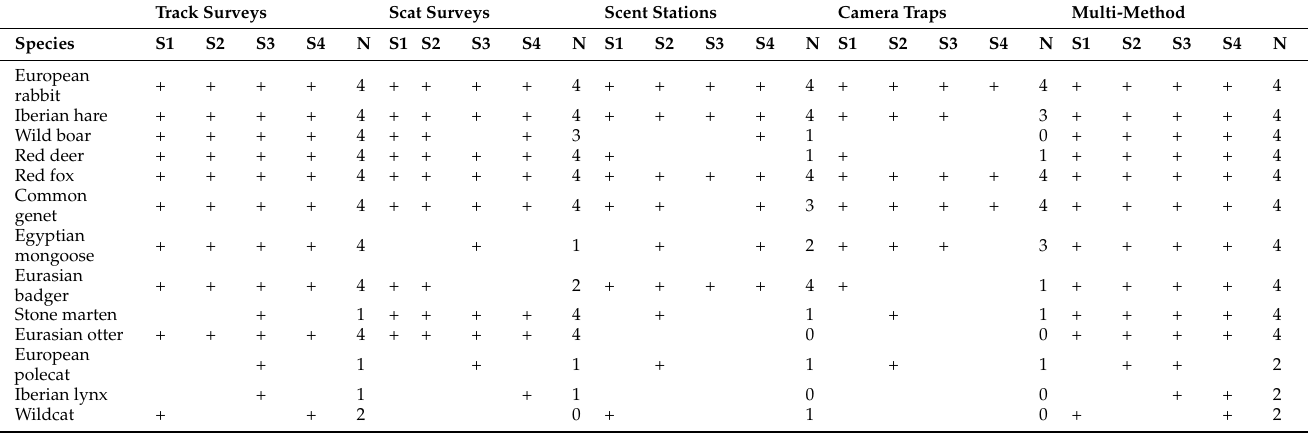
Table 1. The number of sessions (N) in which mammal species were detected (+) by each survey method and by the joint use of all detection methods. The species list contains all wild terrestrial mammals heavier than 0.8 kg known to occur in the study area [37]. Sessions—S1: year 1, spring; S2: year 1, autumn; S3: year 2, spring; S4: year 2,